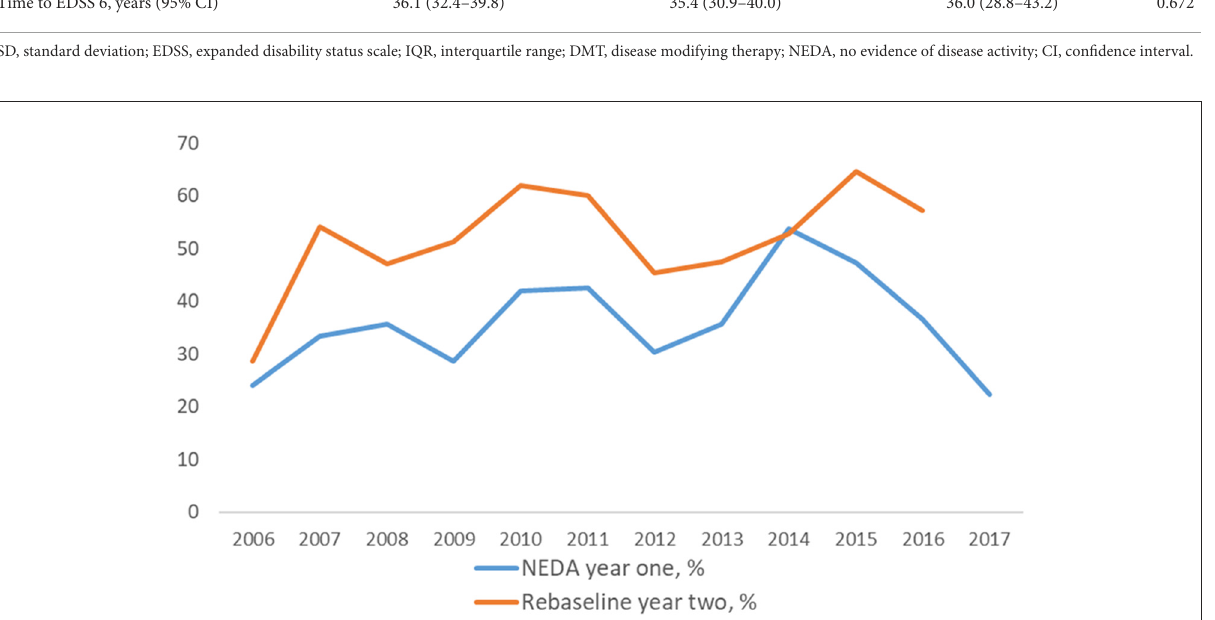
shows the proportion of pwMS who achieved NEDA at